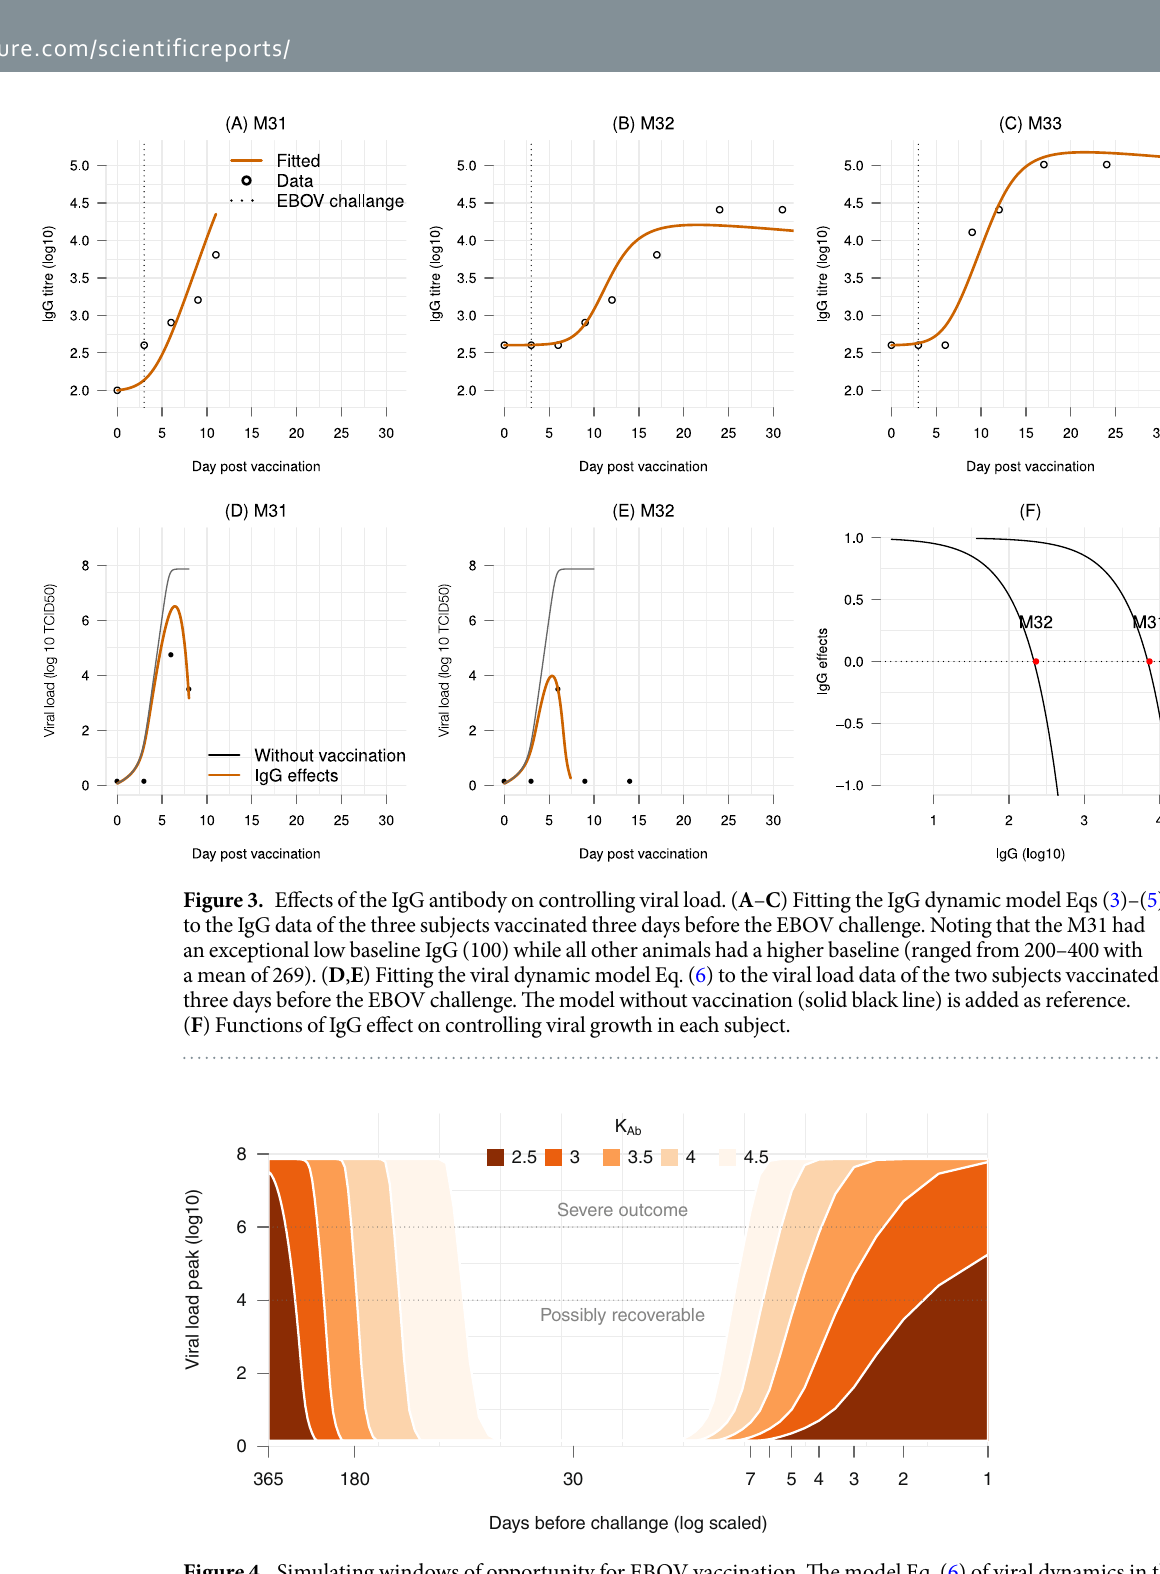
Figure 4. Simulating windows of opportunity for EBOV vaccination. The model Eq. (6) of viral dynamics in the presence of the IgG antibody is used. The x-axis shows the time of vaccination from one year to one day before a subject is challenged with a lethal dose of EBOV. The five shades of color represent the five assumed antibody working threshold ( K Ab )—the darker the stronger the antibody’s effect in inhibiting the viral replication. Each combination of the vaccination time and the working threshold was used to generate the viral replication dynamic from which its peak was retrieved and plotted in the y-axis. For example, the white area indicates the period when the vaccination completely represses the viral replication with K Ab = 4.5. The severe outcome indicates the viral load level that was associated with lethal outcome in EBOV infection in both human 33 and NHPs 4, 10, 11 . It was shown that a viral load reaching 10 4 TCID50 can still be recoverable but not entirely 10